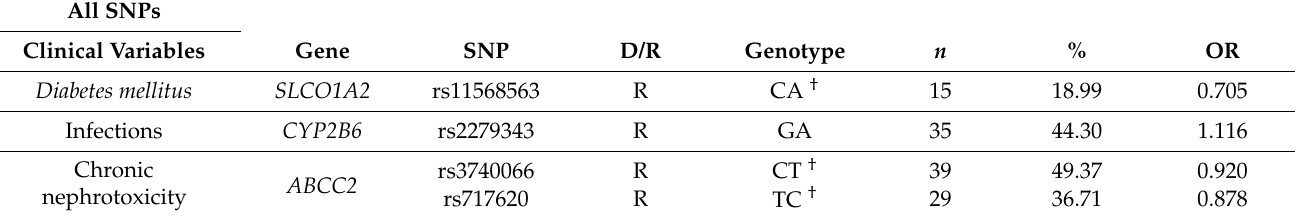
Table 5. Pharmacogene variants associated with other clinical variables selected by multivariate logistic regression and regularized by elastic net statistical analysis. Full panel with all